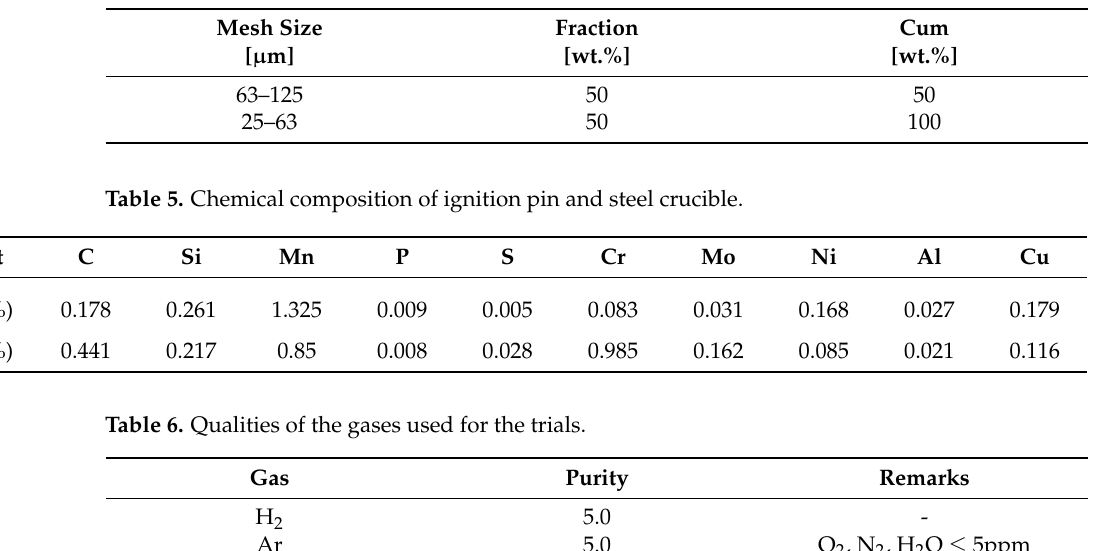
Table 4. The grain size distribution of Carajas iron ore.